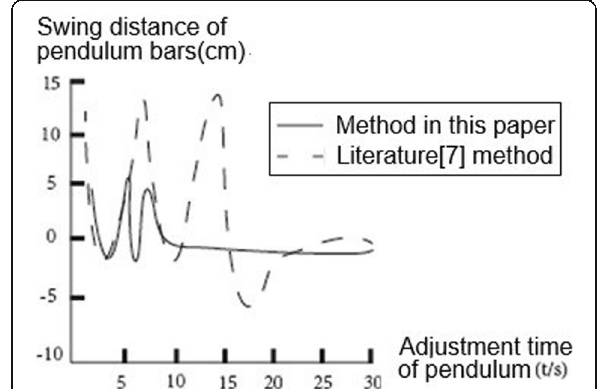
Fig. 3 Comparison of adjustment time curves of pendulum bars of two methods.